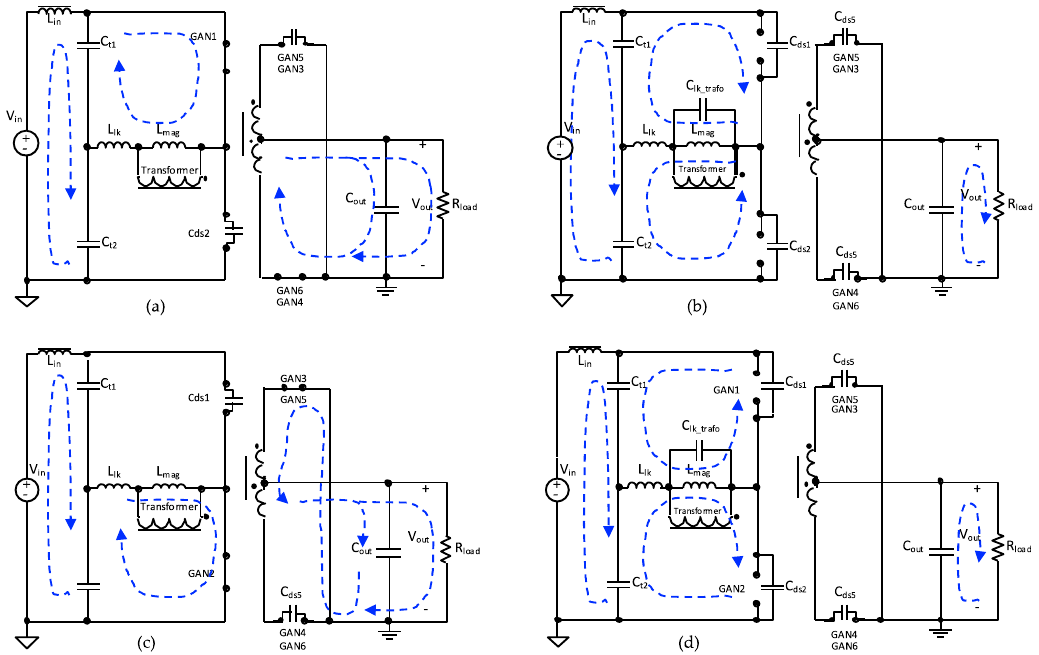
Figure 4. Sub circuit intervals during different operating states of the ZVZCS resonant converter. ( a ) Equivalent circuit during T on1 state (GAN1 ON) ( b ) Equivalent circuit during Tgap1 state (GAN1 and GAN2 OFF). ( c ) Equivalent circuit during T on2 state (GAN2 ON) state. ( d ) Equivalent circuit during Tgap2 state (GAN1 and GAN2 OFF).